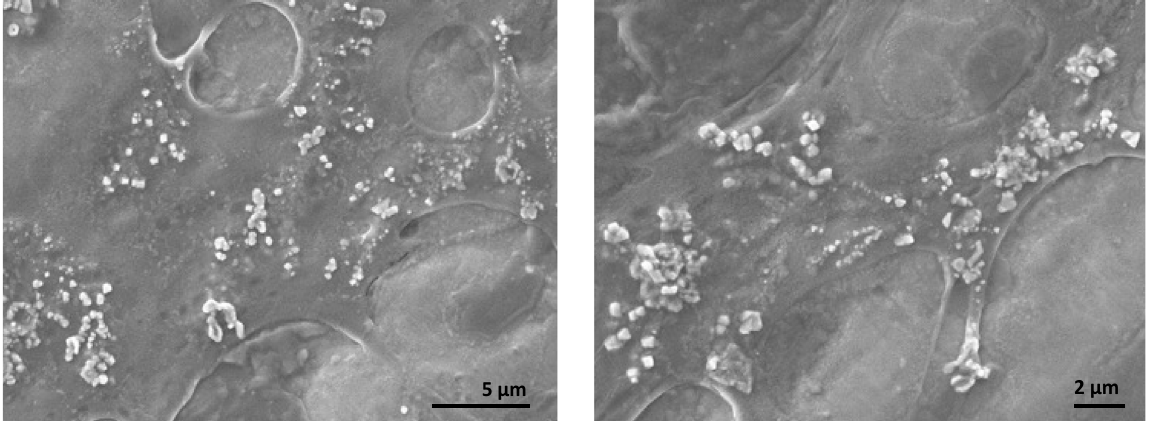
Figure 4. SEM images of CUR/LCSNPs at different magnifications.